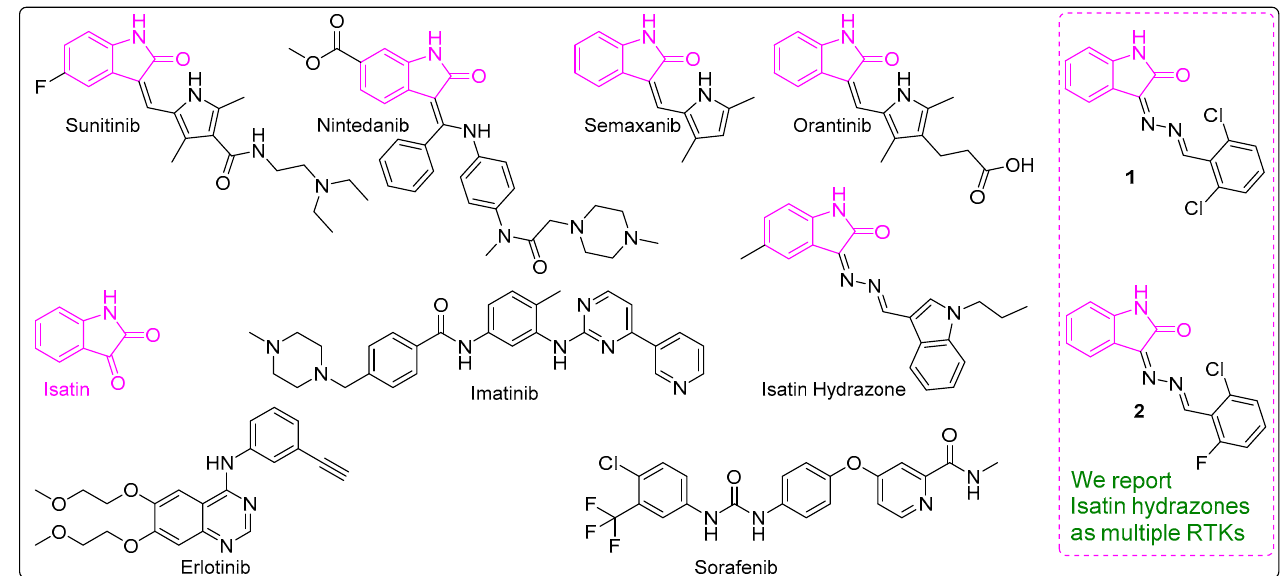
Figure 1. Structure of isatin, some RTKs inhibitors, and Compounds 1 and 2 having isatin skeleton.